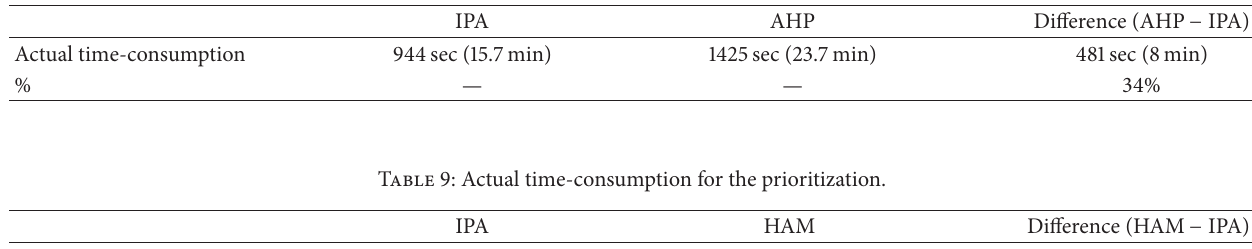
Table 8: Actual time-consumption for the prioritization.